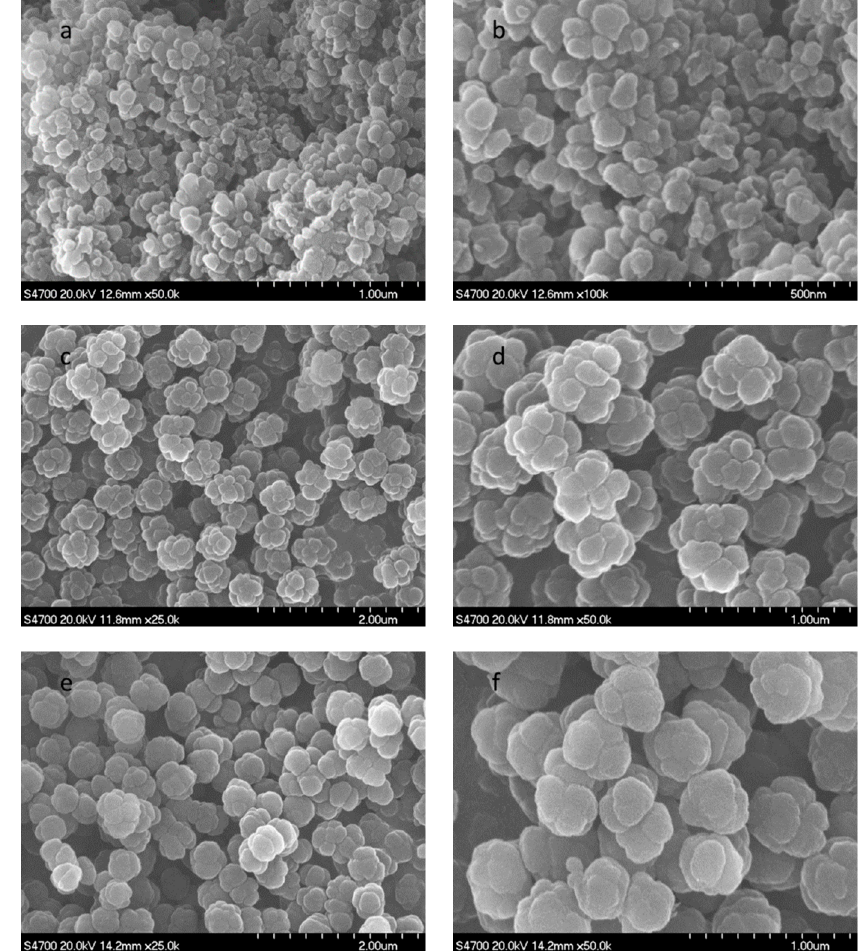
Figure2. ScanningElectronMicroscopy(SEM)micrographsof( a , b )PANhomopolymer, ( c , d )PAN-IA0.5 Figure 2. Scanning Electron Microscopy (SEM) micrographs of ( a , b ) PAN homopolymer, ( c , d ) copolymers, and ( e , f ) PAN-IA1.0 PAN-IA0.5 copolymers, and ( e , f ) PAN-IA1.0 copolymers.